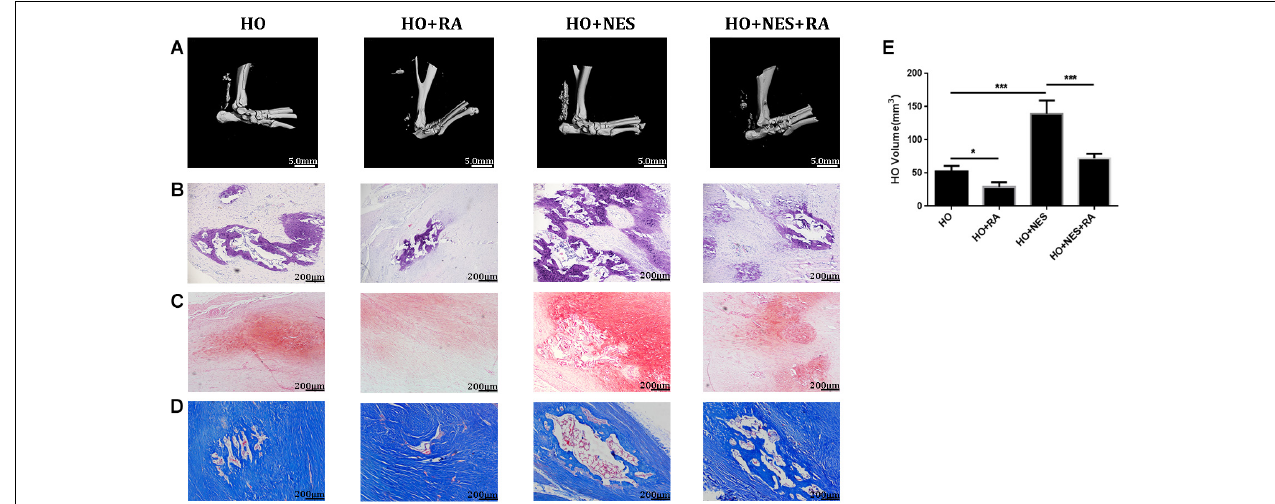
FIGURE 6 | Nesfatin-1 accelerates the pathogenesis of heterotopic ossification in vivo . Sixty rats underwent Achilles tenotomy and were treated with Nesfatin-1 (10 ng/mL) and rapamycin (10 nmol/mL) for 8 weeks. Heterotopic bone formation was measured by micro-CT (A,E) . HE staining (B) , Safranin O staining (C) and modified Masson staining (D) were performed for histological analysis. The values are expressed as the mean ± standard deviation (SD). * p < 0.05, ** p < 0.01 vs. the control group. Scale bar, 200 µ m. *** p <